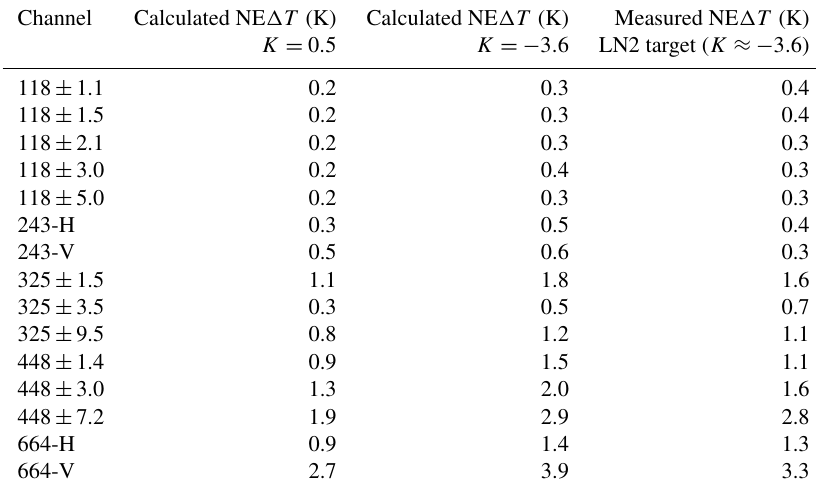
Table 3. NE (cid:49)T estimates for ISMAR